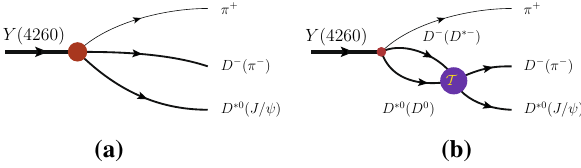
Fig. 1 The diagrams for the Y ( 4260 ) decay. Diragrams a and b are for background and rescattering contribution